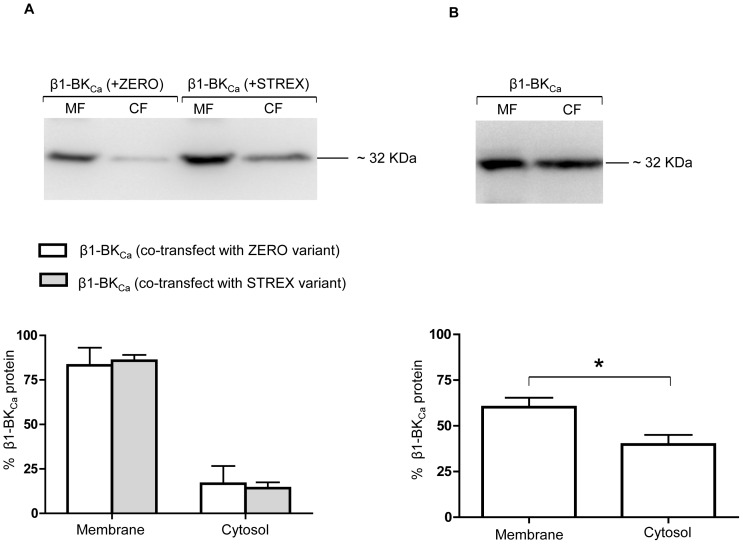
Cell surface expression of β1-BKCa subunit in the presence and absence of α-BKCa splice variants.Co-transfection of ZERO or STREX variants with β1-BKCa subunit enhances cell surface trafficking of β1-BKCa subunit. The top image in panel (A) represents a Western blot for membrane (MF) and cytosolic (CF) fractions of β1-BKCa protein in CHO-K1 cultured cells, co-transfected with either α-BKCa splice variants ZERO or STREX. The bottom Figure in panel (A) shows the membrane vs cytosolic expression of transfected β1-BKCa channel protein when co-transfected with either α-BKCa splice variants of ZERO or STREX. Results are shown for n = 5 separate experiments. The top image in panel (B) shows a representative Western blot of membrane (MF) and cytosolic (CF) fractions of β1-BKCa protein in CHO-K1 cultured cells, in the absence of either α-BKCa splice variants ZERO or STREX. The bottom Figure in panel (B) shows membrane vs cytosolic expression of β1-BKCa subunit in cultured CHO-K1 cells in the absence of the α-BKCa splice variants ZERO or STREX. Results are shown for n = 6 separate experiments and are presented as mean ± SEM (*P<0.05, unpaired t-test).